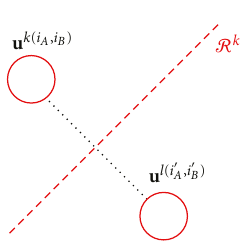
Figure 4: Visualization of the pairwise boundary in the constella- tion